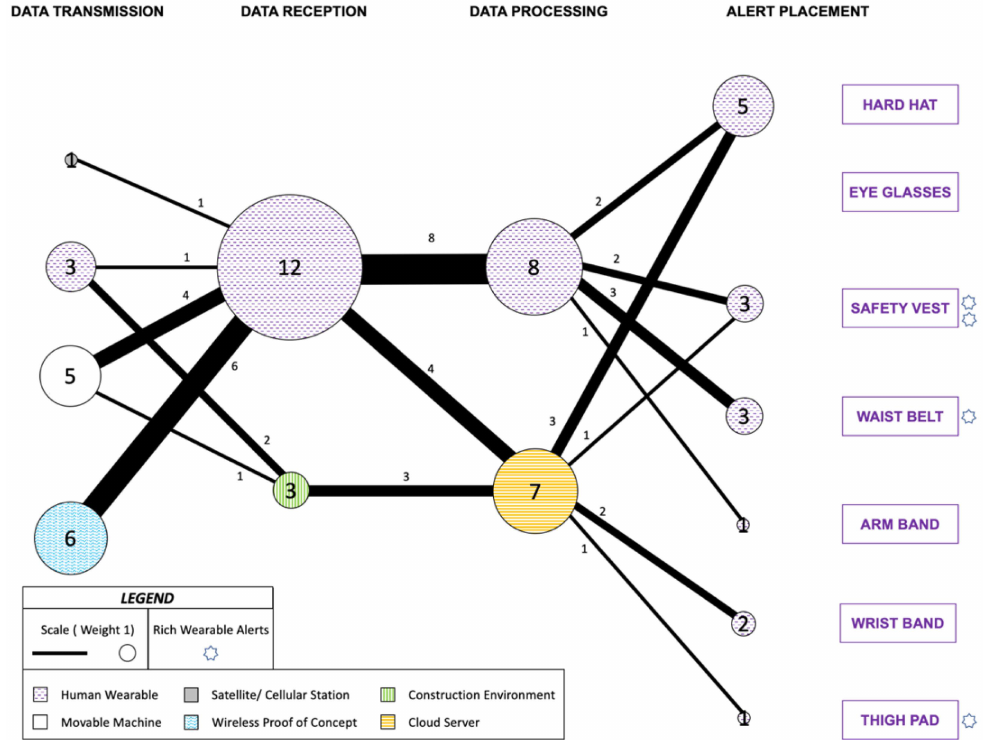
Figure 6. The Tactile Communication Network for conveying information through sense of touch, replicated using vibration motors, to the construction worker-on-foot as per the reviewed literature. Digits inside the nodes and next to the routes display the frequency of